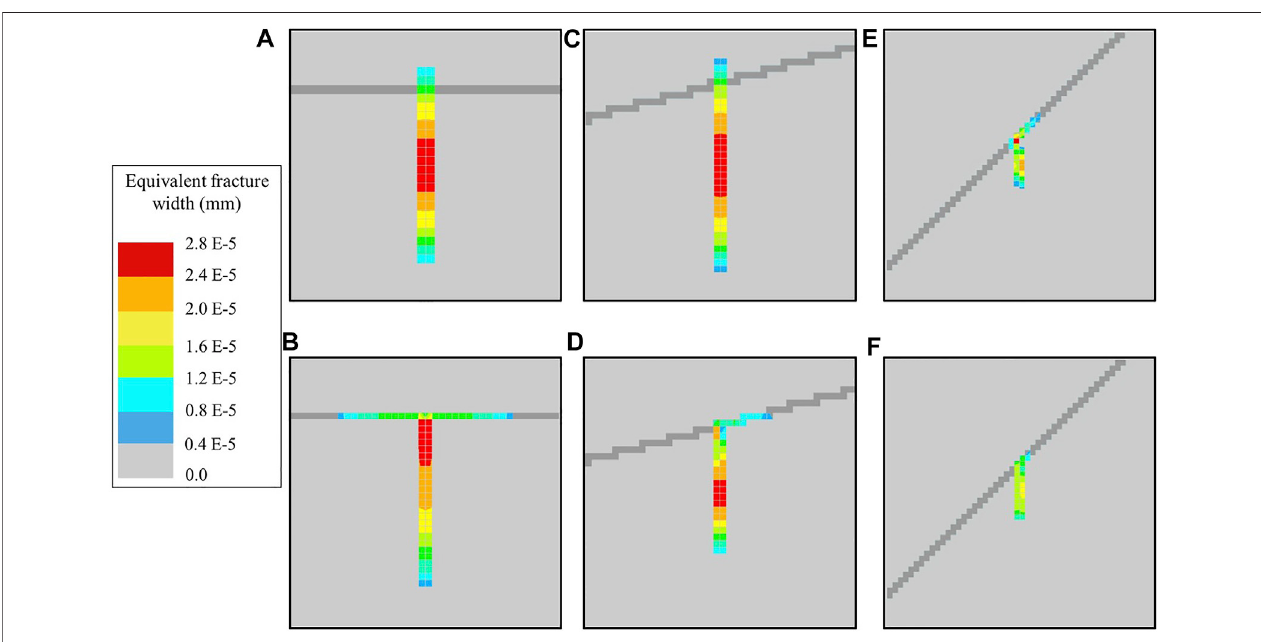
FIGURE 5 | Width of HF (A) Case 1, (B) Case 2, (C) Case 3, (D) Case 4, (E) Case 5 and (F) Case 6.